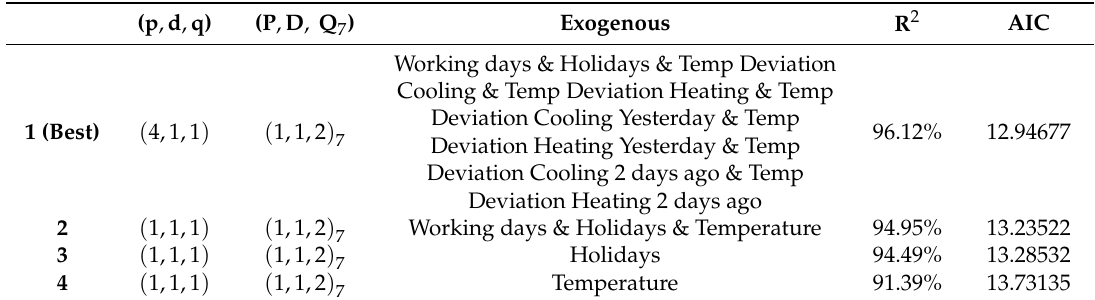
Table 8. A comparative list of the prediction efficiency and parameters selection of the SARIMAX models fitted on load series.